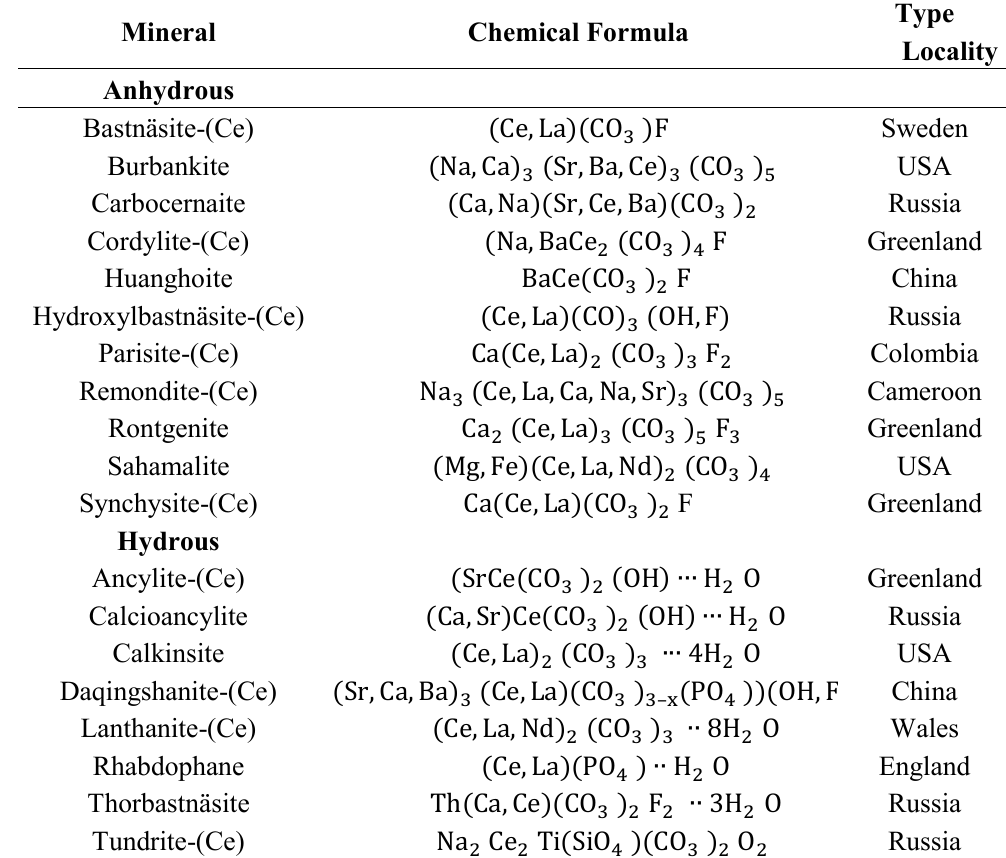
Table 4. Several members of the rare earth anhydrous and hydrous carbonates. Modified after